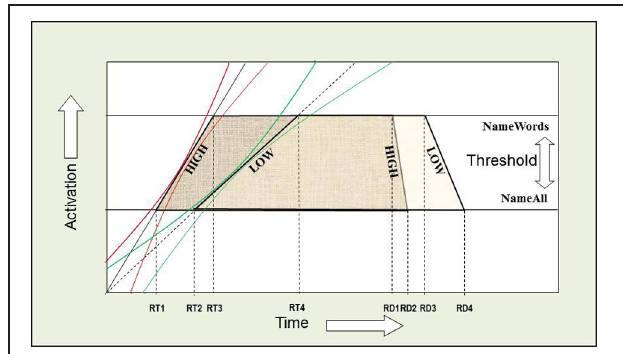
FIGURE 14 | Over-additive interaction on RT between INST and WF. An AFM interpretation of this interaction on RT is that both INST and WF are affecting a common system in time. If INST are assumed to affect the threshold for activation and WF is assumed to affect the rate of activation over time, or vice versa, then the points in time when each rate crosses a threshold correspond to the average onset RTs (the left side of each trapezoid). WF and WT interact on RT in a similar fashion. The red and green confidence intervals around the slopes allow for trial to trial variation. The effects of WF on RD remain negative when compared to RT. We note that SND effects can be accounted for in a similar manner. The effects of INST on RD represent the dissociation when compared to RT. The right side of each trapezoid represents the RD and illustrates this